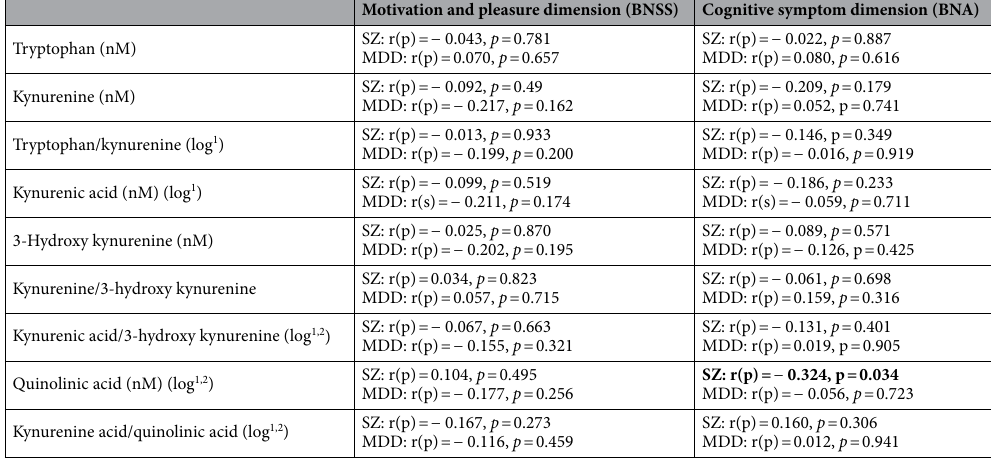
Table 3. Correlations between TRY CAT s and psychopathological dimensions. Statistics: 1 log 10 -transformation achieved normal distribution in patients with SZ, 2 log 10 -transformation achieved normal distribution in patients with MDD. BNA Brief Neurocognitive Assessment, BNSS Brief Negative Symptom Scale, HC Healthy controls, MDD Major depressive disorder, SZ Schizophrenia. Data is presented as mean ± standard deviation. The level of significance was set at p < 0.05 (significant p -values are indicated in bold).